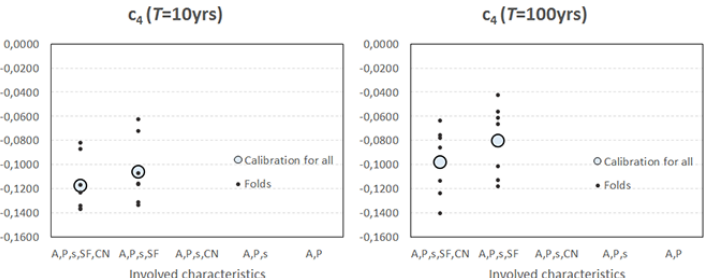
Figure 24. Values of parameter c 4 calibrated to the whole data set and to 7 folds for N = 10 years (left panel) and N = 100 years (right